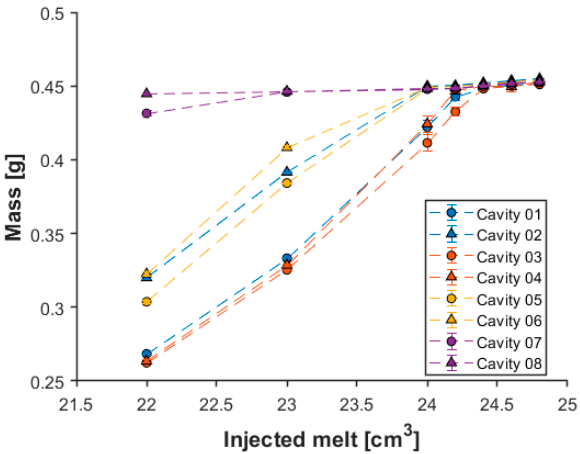
Figure 7. Change of part weight due to the injected melt volume.